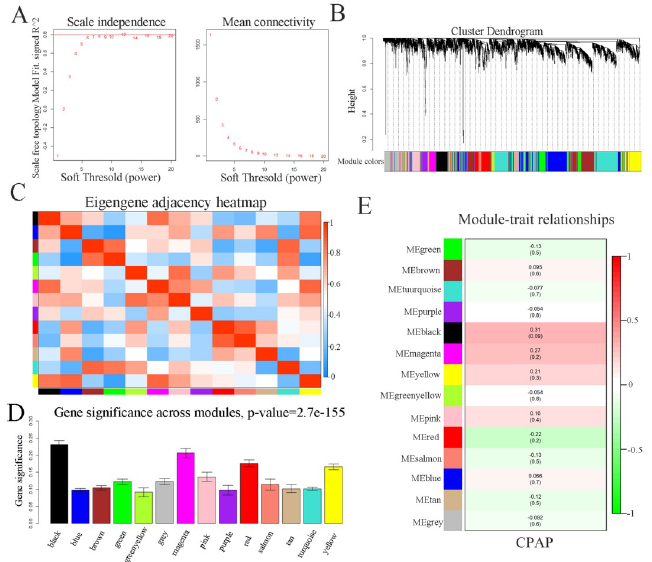
Fig 2. Weighted correlation network analysis. (A) Analysis of scale-free fit parameter and mean connectivity for various soft-thresholding powers. (B) Cluster dendrogram of genes, with dissimilarity based on topological overlap. (C) Co-expression similarity of entire modules based on hierarchical clustering of module eigengenes and the correlation between different modules. The color of cells in the heatmap represented the correlation coefficients of different sizes. Specifically, red colors stood for the positive correlations and blue colors represented the negative correlations. (D) Distribution of average gene significance and errors in the modules associated with the response to CPAP therapy. (E) Correlation heat map of gene modules and phenotypes. The figure without brackets in each cell indicated the clinical feature correlation coefficients. The corresponding p-value was shown below in parentheses. Red is positively correlated with the phenotype; green is negatively correlated with the phenotype.